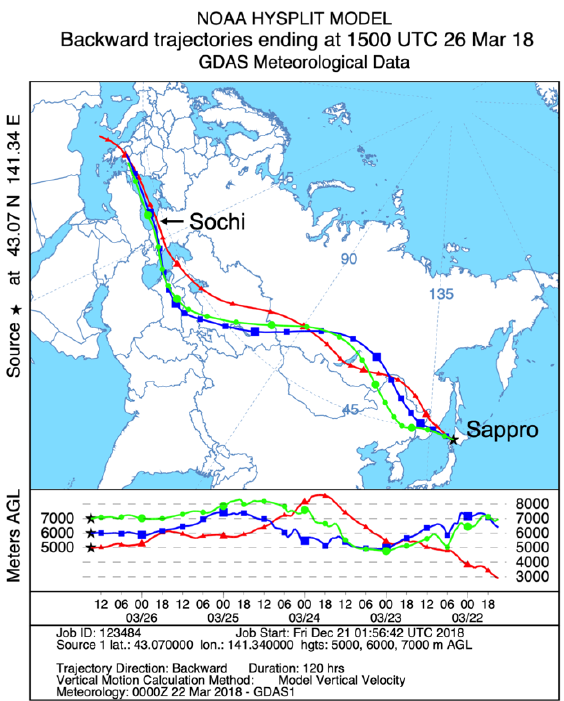
Fig.2 HYSPLIT backward trajectory of the Sahara dust plume indicated in Fig.